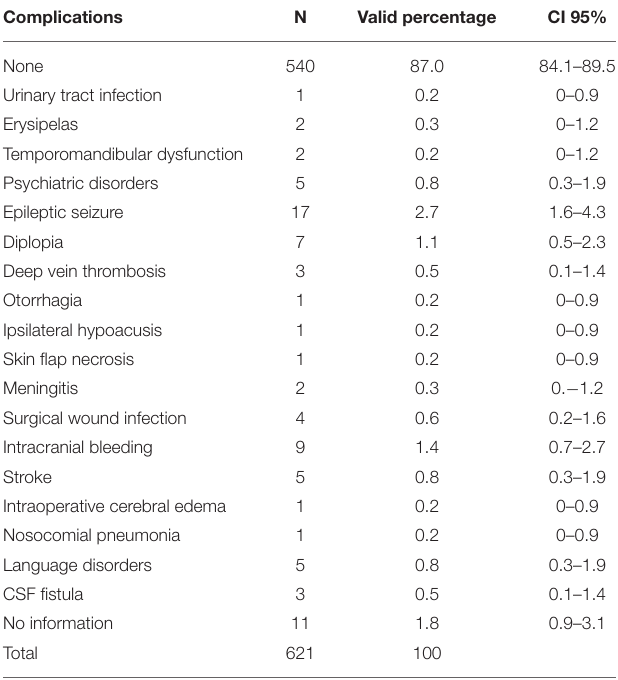
TABLE 4 | Immediate postoperative complications.